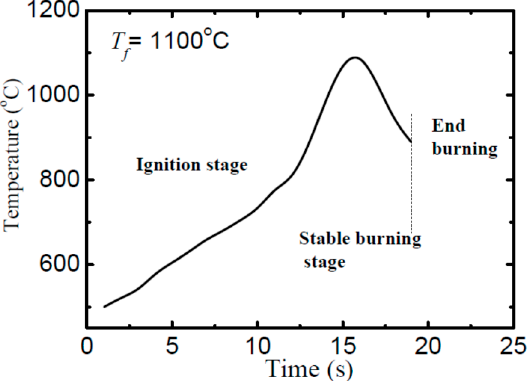
Figure 3. A representative temperature profile measured at the center of the sample (obtained from forging temperature of 1100 °C). A preheating process at 500 °C was carried out before burning test to accelerate the ignition.